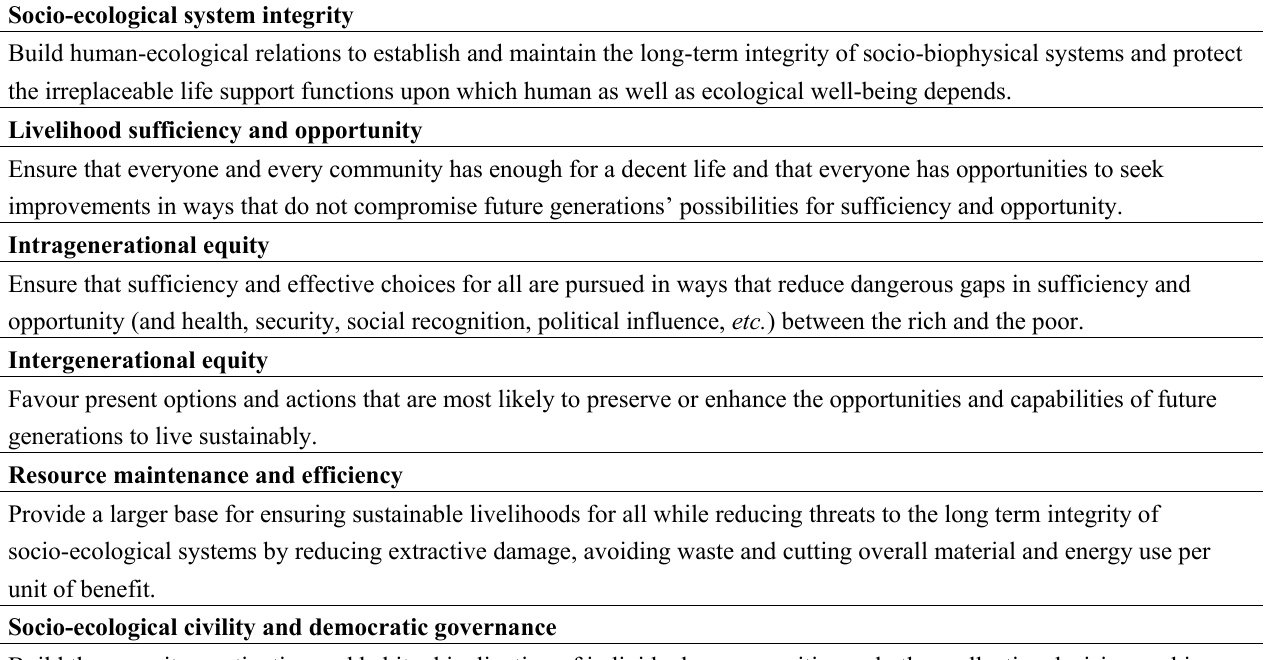
Table 1. Sustainability assessment decision criteria